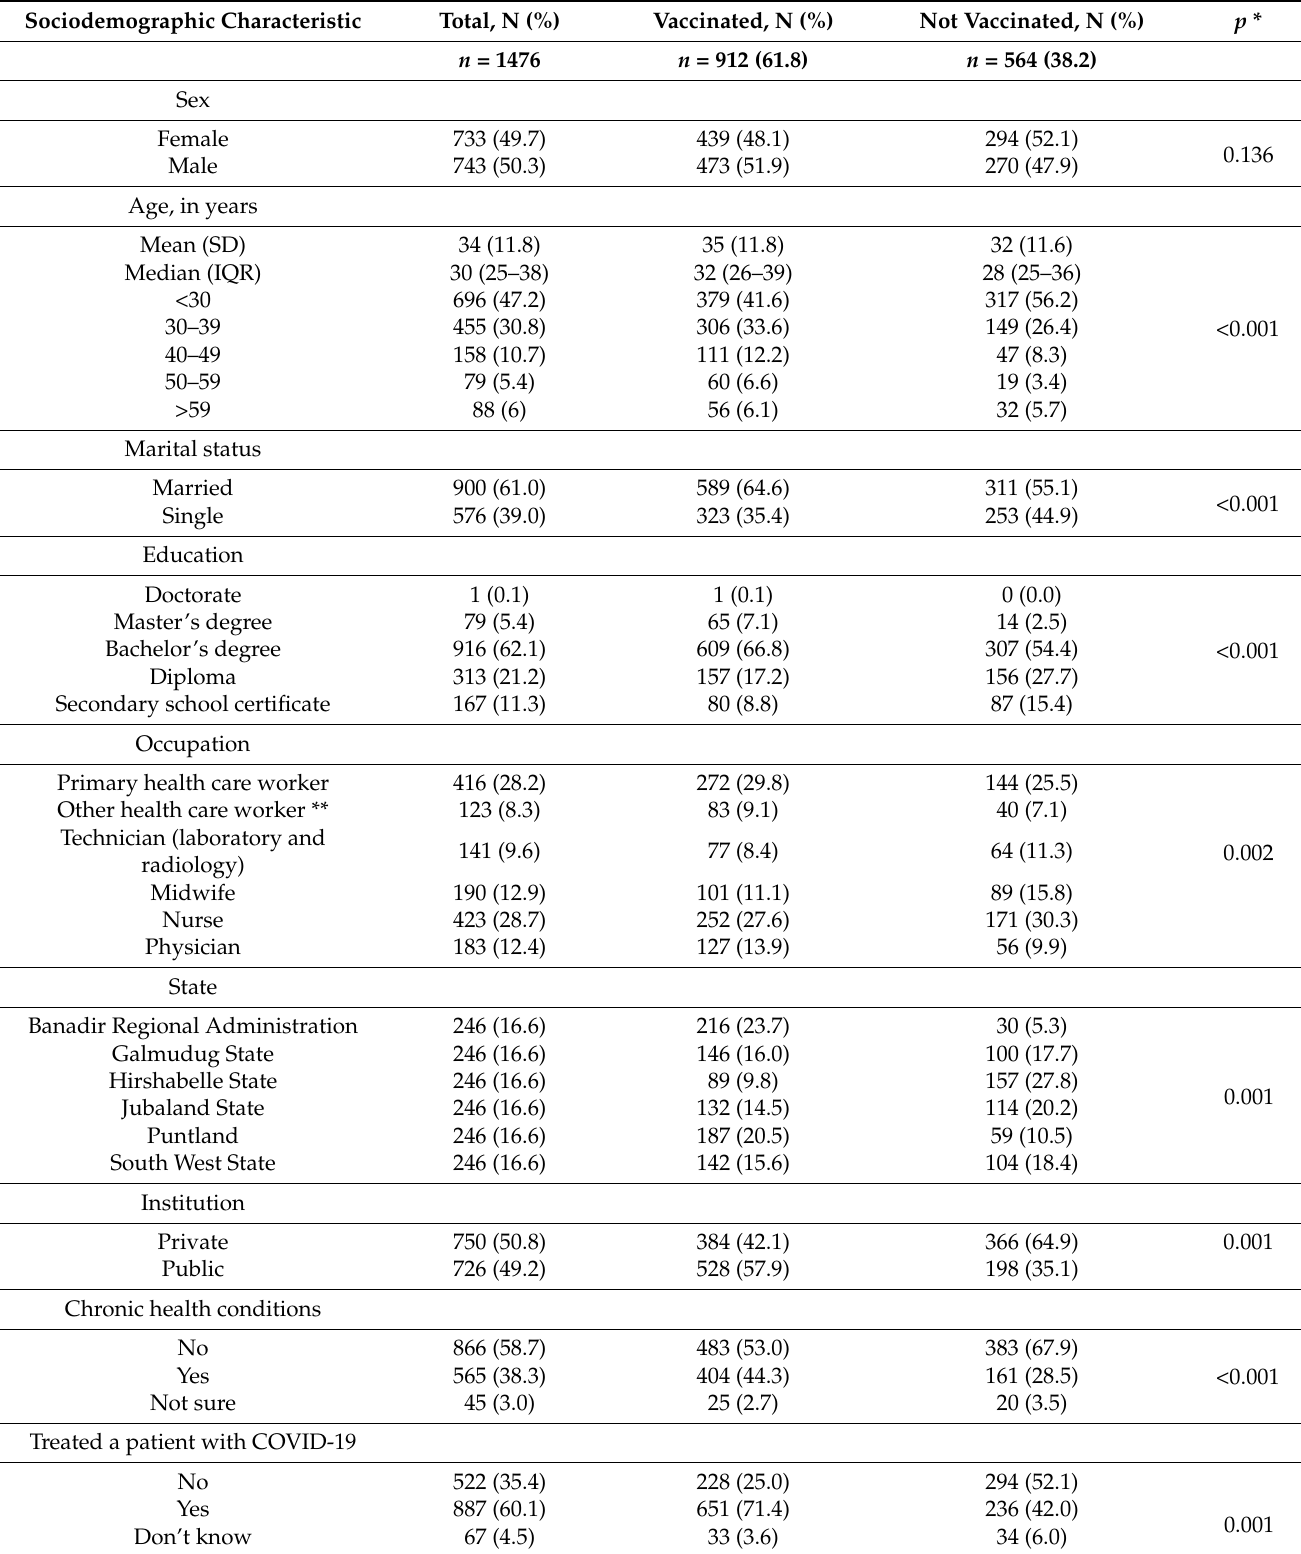
Table 1. Sociodemographic characteristics of study